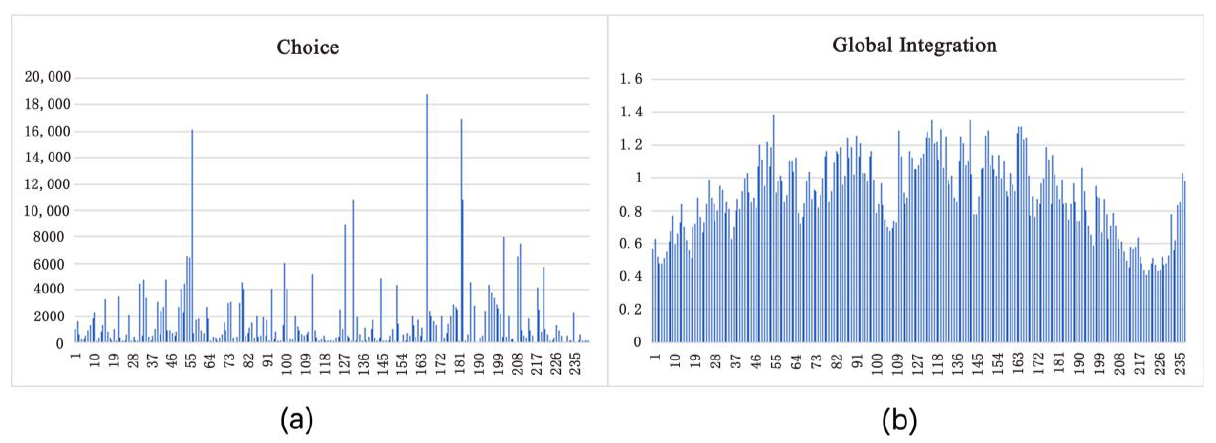
Figure 6. Column chart of global integration and choice: ( a ) axis choice; ( b ) axis global integration.